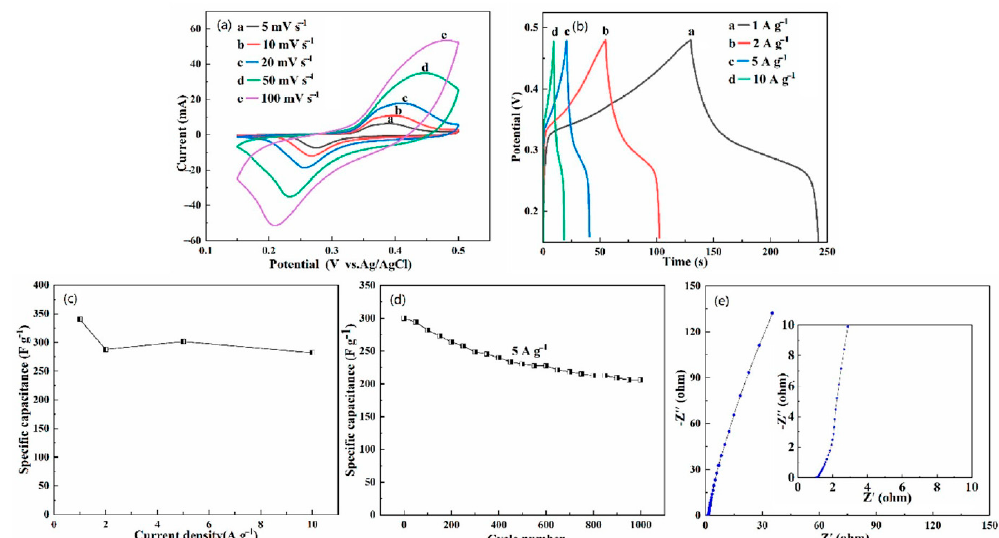
Figure 5. Electrochemical characteristics of the (FeCoCrMnZn) 3 O 4 / nickel foam (NF) composites: ( a ) cyclic voltammetry (CV) curves, ( b ) galvanostatic charge-discharge (GCD) curves, ( c ) corresponding specific capacitance (SCs) at different current densities, ( d ) cycling performance at a current density of 5 A·g − 1 , and ( e ) electrochemical impedance spectra (EIS).